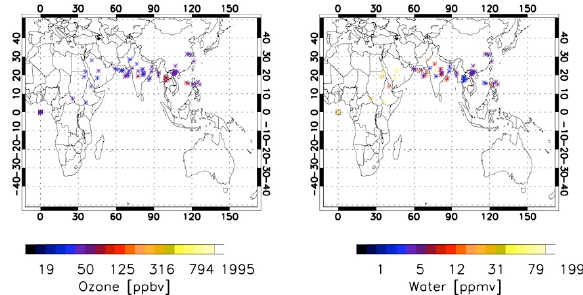
Fig. 5. Starting points of 10-day back trajectories initialised along the M55 flight tracks south of 18 ◦ N colour coded in terms of theta variations (K) along the back trajectories (left panel) and pressure at the starting point of the back trajectory, i.e. along the M55 flight path (right panel).